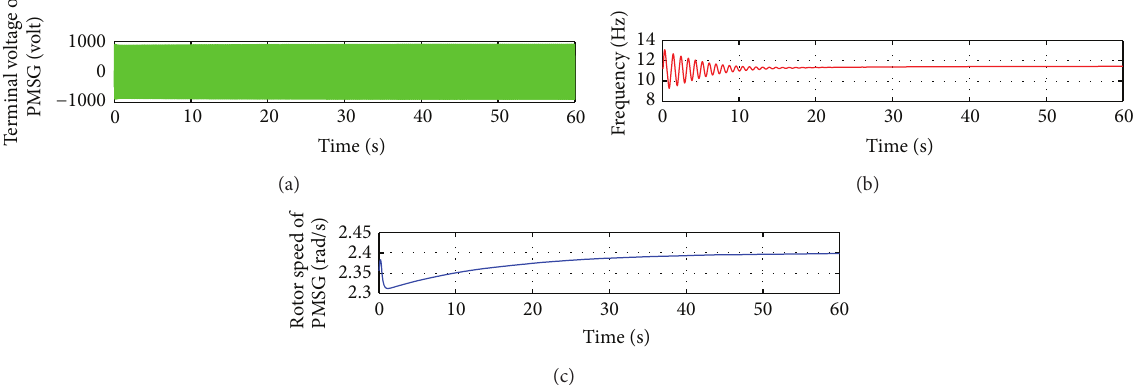
Figure 6: Output voltage, frequency, and rotor speed variation curves of PMSG-based VSWECS without IGBT-PWM power converter.